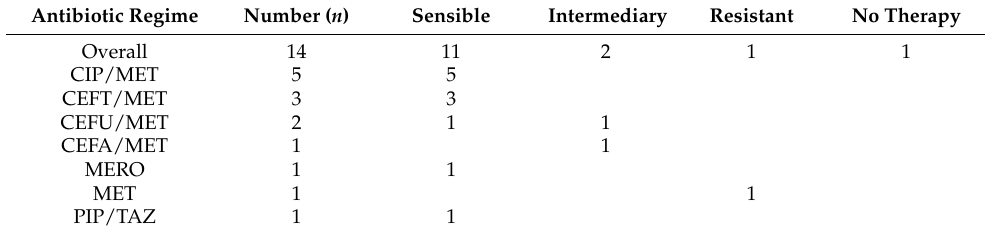
Table 4. Empiric antibiotic therapy and resistance profile for E. coli